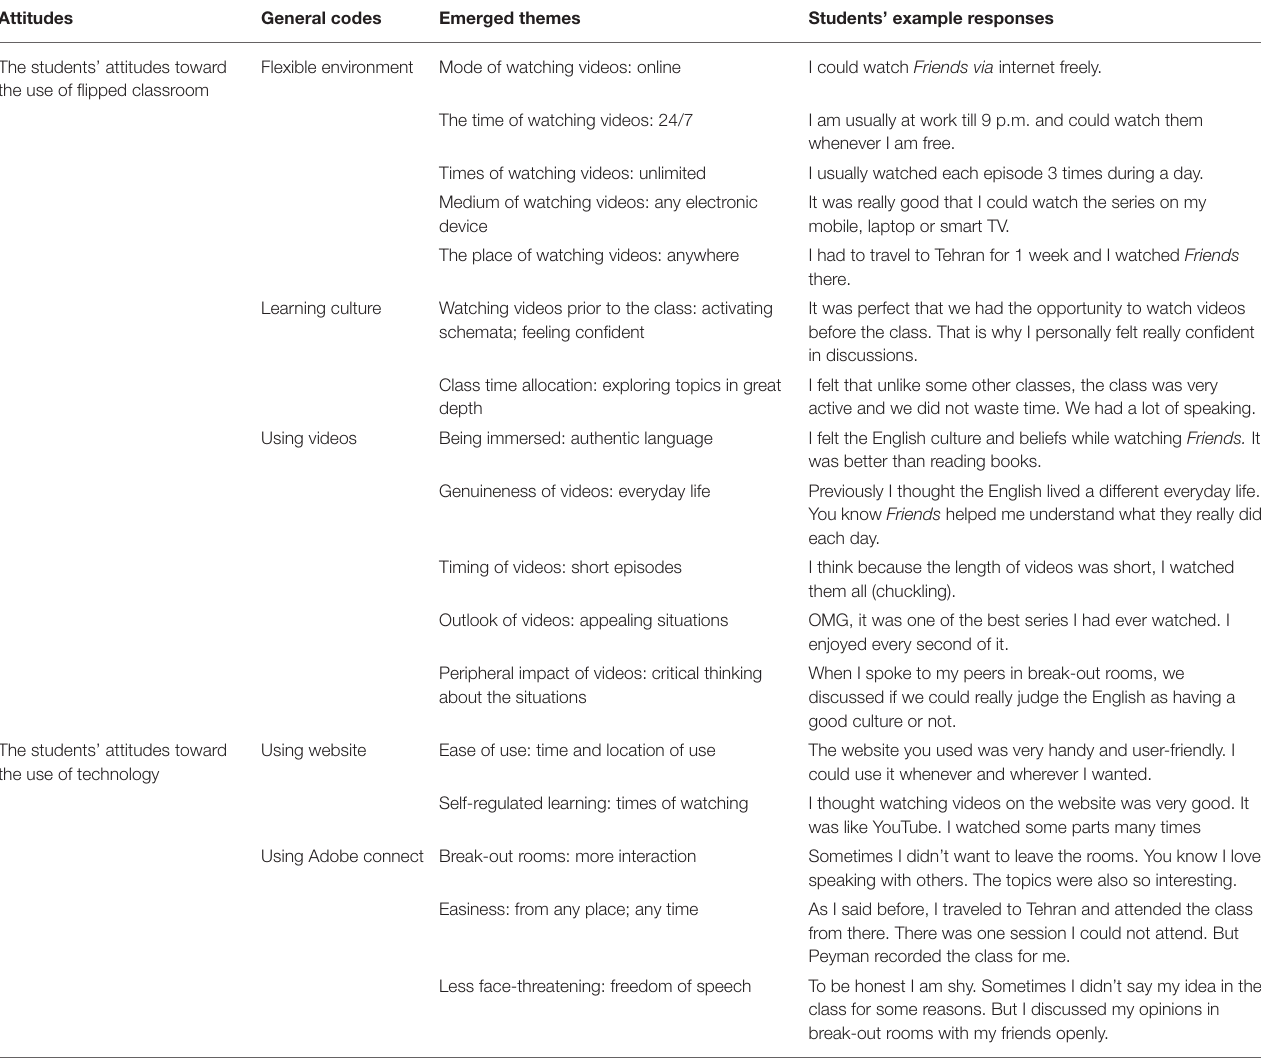
TABLE 4 | General themes developed from semi-structured